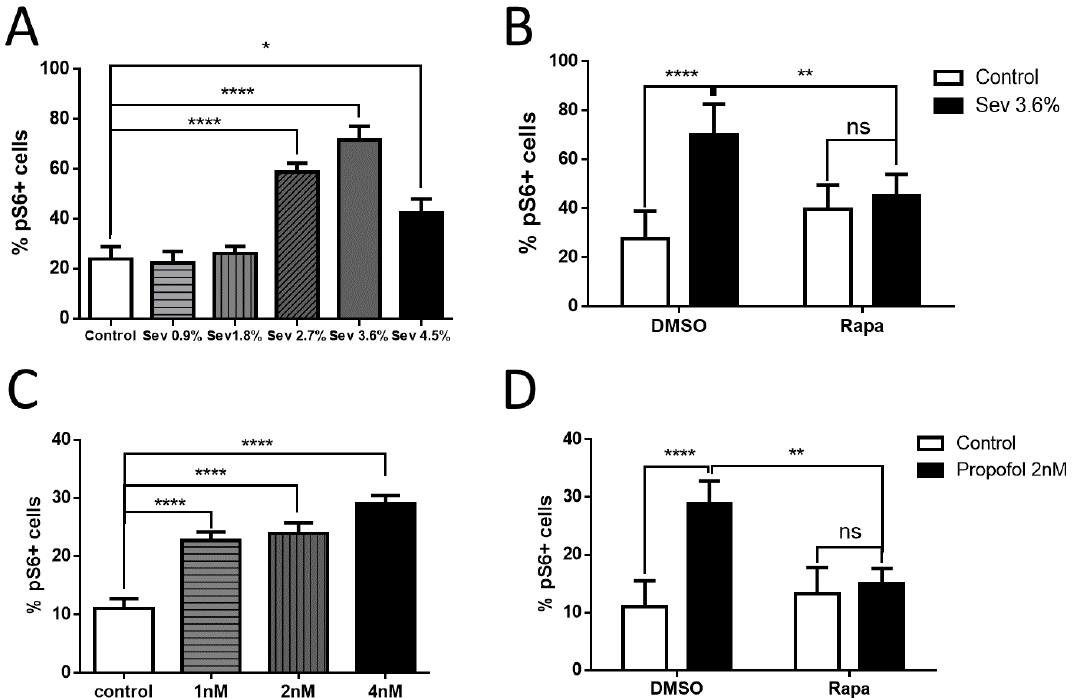
Figure 6. Effects of sevoflurane and propofol on the downstream marker of the mTOR pathway. ( A , B ) The effect on pS6 levels at 10 DIV varied depending on the doses of sevoflurane at 7 DIV. There was a significant increase in immunoactivity starting from the 2.7% sevoflurane group to the 4.5% sevoflurane group, while lower doses (0.9% and 1.8%) remained at control levels of pS6 ( A ). Rapamycin treatment prevented the increase in pS6 labeling with 3.6% sevoflurane exposure ( B ). ( C , D ) Different doses of propofol at 7 DIV had similar effects on pS6 levels at 10 DIV. There was a significant increase in pS6 immunoactivity starting from the 1 nM propofol group to the 4 nM propofol group ( C ). Rapamycin treatment prevented the increase in pS6 labeling with 2 nM propofol exposure ( D ). ( n = 15 fields that were measured per group, * p < 0.05, ** p < 0.01, **** p < 0.0001, n.s. indicates no significant difference, one-way ANOVA with Dunnett’s multiple comparisons test for ( A , C ), two-way ANOVA with Bonferroni’s multiple comparisons test for ( B , D ).